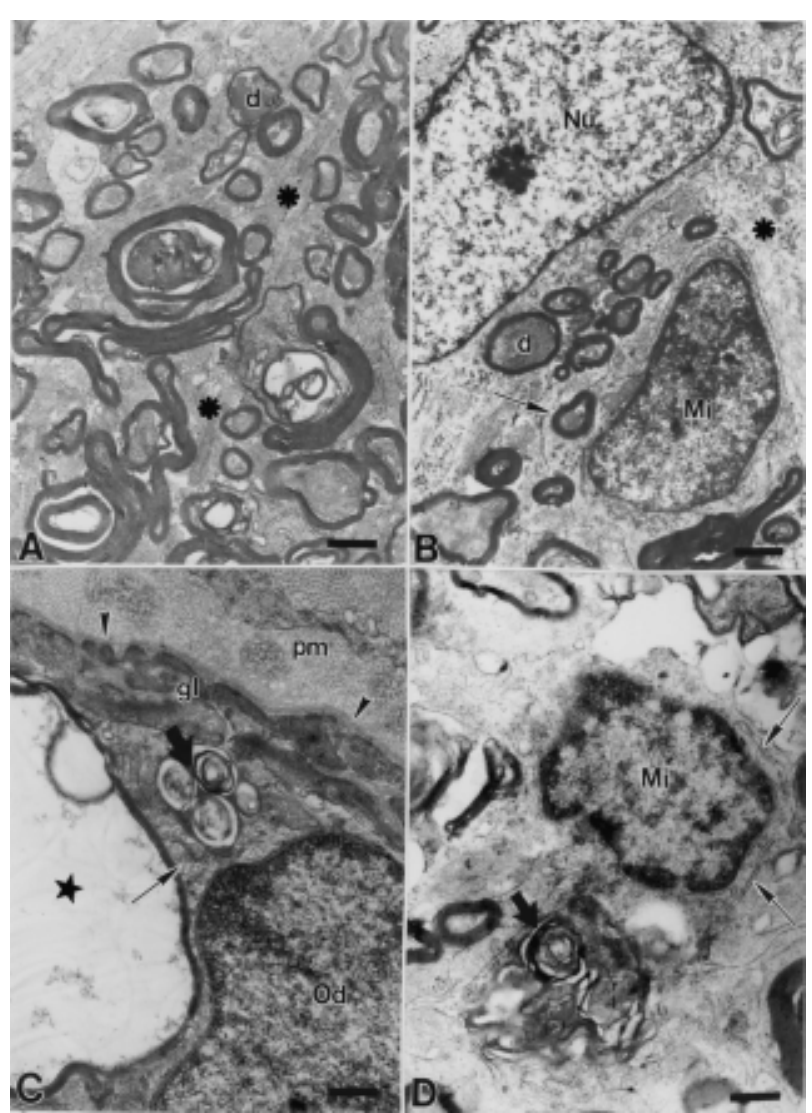
Fig. 4 – Electron micrographs of opossum’s optic nerve fibers undergoing Wallerian degeneration, 168 hours after crush. A. Presence of many astrocytic processes (asterisks) causing distortion of the nerve fascicles. Note fibers with a dense axoplasm, typical of dark degeneration (d). Bar = 1 . 1 µ m. B. A hypertrophic astrocyte, with thick hyperfilamentous processes (asterisk) and an euchromatic nucleus (Nu) showing an evident nucleolus, is visualized in this field next to a microglial cell (Mi), which has scanty cytoplasm and a more heterochromatic nucleus. Note many fibers undergoing dark degeneration (d), and one of them seems to be engulfed by the microglia (arrow). Bar = 1 . 1 µ m. C. Periphery of the optic nerve, in which we can observe astrocytic processes of the glia limitans (gl) abutting the basal lamina (arrowheads). Observe an enlarged fibre (star), with a pale axoplasm, devoid of organelles, showing typical watery degeneration. Next to it, is an oligodendrocyte (Od), whose cytoplasm exhibits many microtubules (thin arrow), and presents vacuoles containing myelin debris (thick arrow). pm, pia mater. Bar = 0 . 6 µ m. D. Microglial cell (Mi) with much phagocytosed myelin debris (thick arrow) within its cytoplasm. Observe the slender REG cisternae (thin arrows) around the nucleus. Degenerating fibers and myelin debris occur in the neighbourhood. Bar = 0 . 6 µ